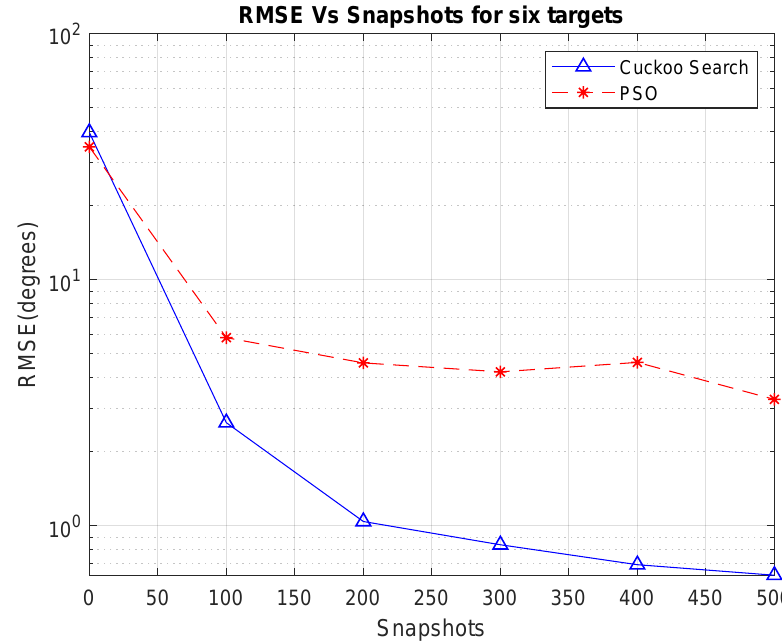
Figure 7. Estimation of robustness using six sources in terms of